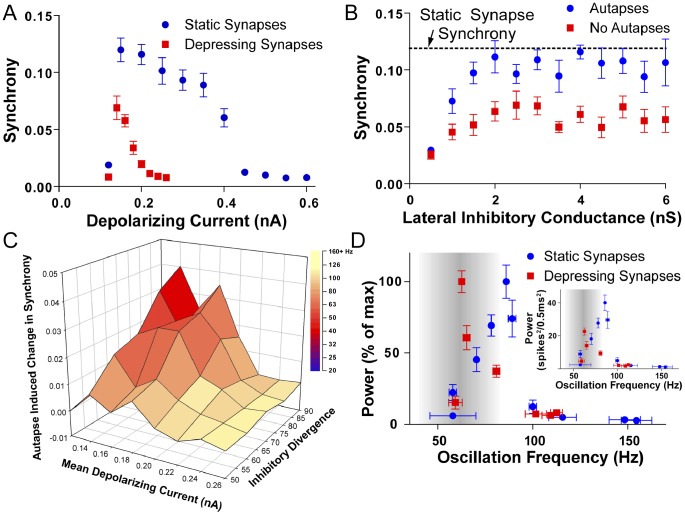
The effect of depressing synapses on the WB model of gamma oscillations.
A. Including depressing synapses in the WB model reduces the peak synchrony as well as the range of depolarizing current that can produce synchronous oscillations. B. The average lateral inhibitory conductance needs to be doubled before networks with depressing synapses can produce oscillations as synchronous non-depressing networks. The dotted line represents the mean synchrony of the network under identical conditions apart from using non-depressing synapses. C. Even in a network with depressing synapses, autapses enhance synchrony. D. Depressing synapses help constrain oscillations to the gamma band. During various levels of depolarizing drive, the network produces oscillations across different frequencies (larger depolarization generates higher frequencies). By analyzing the peak spectral power of spike times of the network, it can be seen that networks with depressing synapses are tuned to oscillate at 60 Hz range, while non-depressing networks are tuned to 90 Hz. Inset, a non-normalized representation of the power of the oscillation against frequency. A, B and D were run with inhibitory divergence of 70, gap junctional coupling of 10 and a depolarizing current of 0.15 nA.